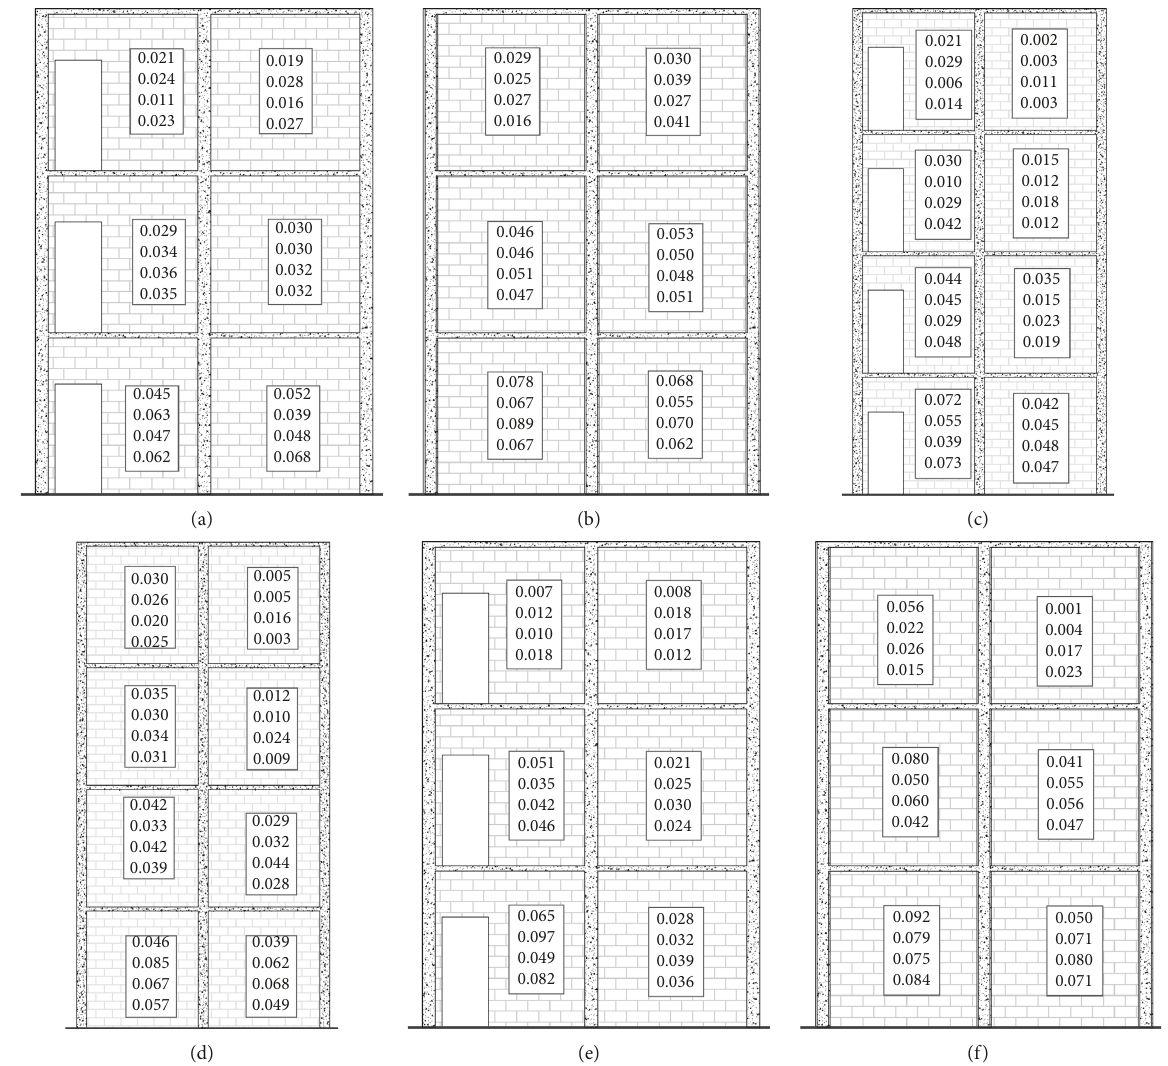
Figure 8: Calculation results of wall importance coefficient. (a) Axis 2&3 coefficients of each wall in the figure are calculated using the elastic-plastic strain energy method, the generalized elastic-plastic strain energy method, the generalized stiffness method, and the ultimate bearing capacity method,